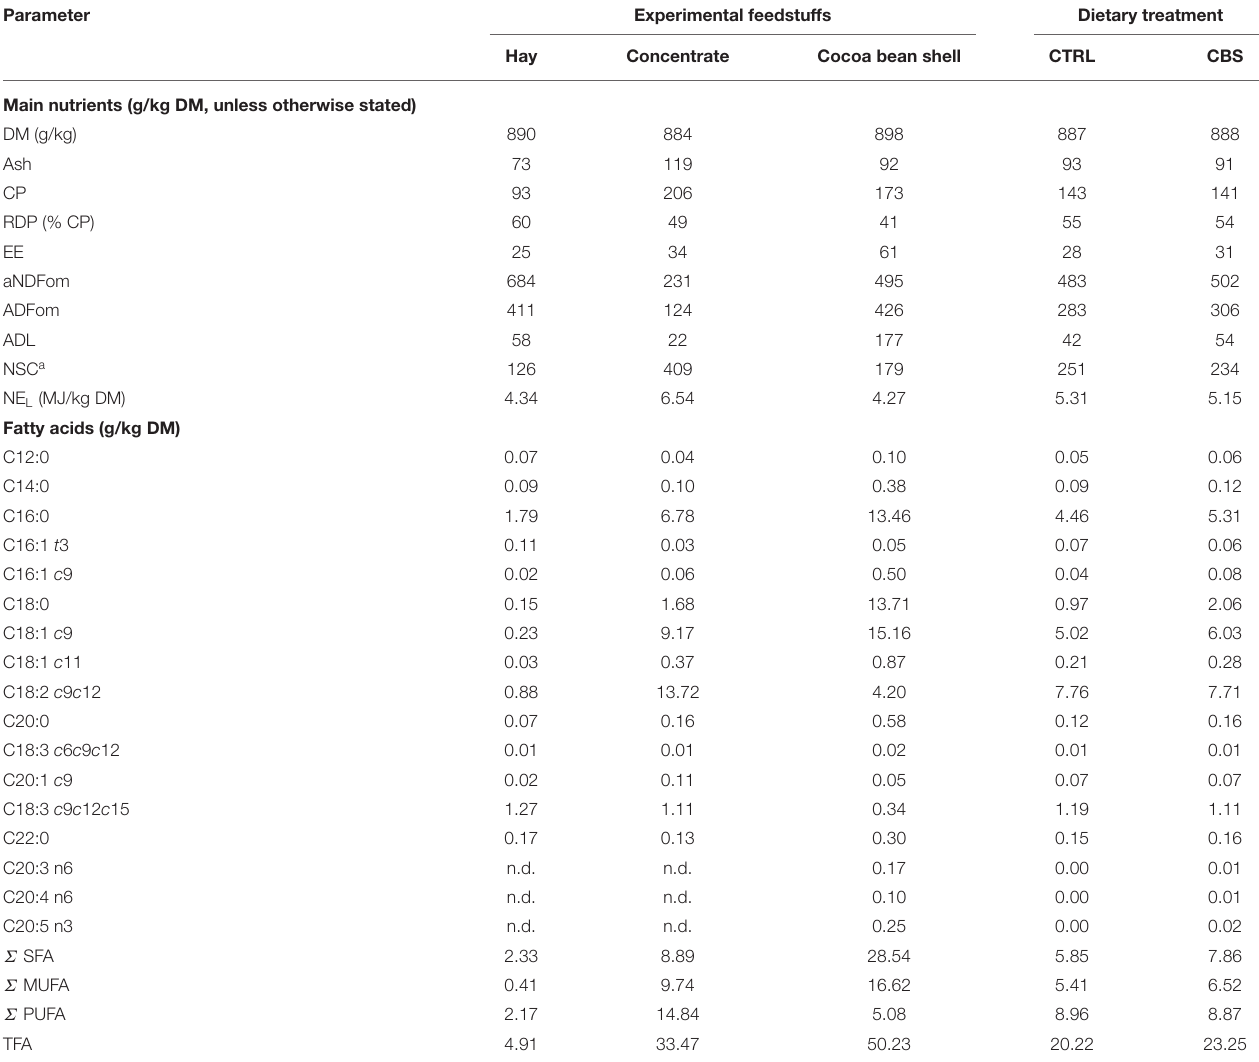
TABLE 1 | Proximate composition (g/kg DM, unless otherwise stated) and fatty acid profile (g/kg DM) of the experimental feedstuffs. Parameter Experimental feedstuffs Dietary treatment Hay Concentrate Cocoa bean shell CTRL CBS Main nutrients (g/kg DM, unless otherwise